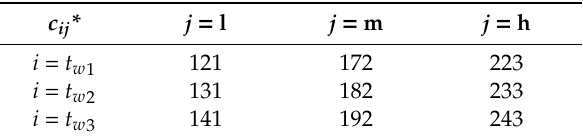
Table A9. Post-COVID unit costs of the 9 mixes under consideration.